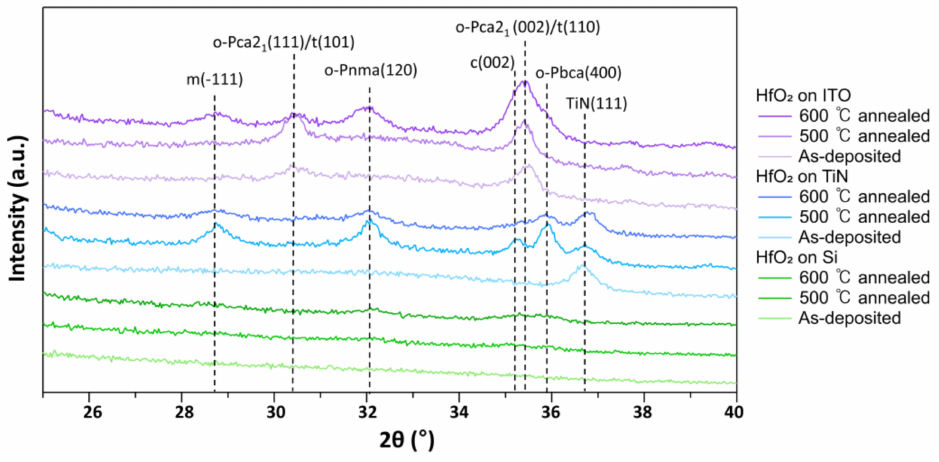
Figure 6. GIXRD of HfO 2 film of as-deposited state and annealed state on Si, TiN, and